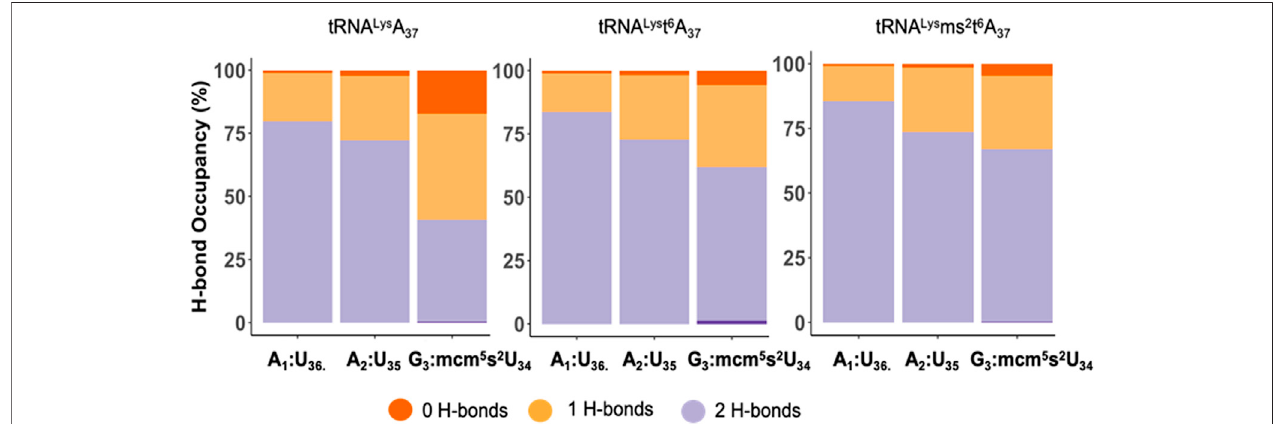
FIGURE 5 | The hydrogen bond occupancy for the tRNA Lys3 anticodon-codon base pairs. The hydrogen bond (H-bond) occupancy for the tRNA Lys3 anticodon- codon base pairs for the mcm 5 U 34 U 35 U 36 anticodon interacting with the A 1 A 2 G 3 wobble codon for the three cases of tRNA Lys3 -A 37, tRNA Lys3 -t 6 A 37 and tRNA Lys3 - ms 2 t 6 A 37 .ThechartpresentstheH-bondoccupancyforthepercentageofthesimulationtimethebase-pairs,A1:U 36, A2:U 35 ,G3:mcm 5 s 2 U 34 interactandestablish0,1, or 2